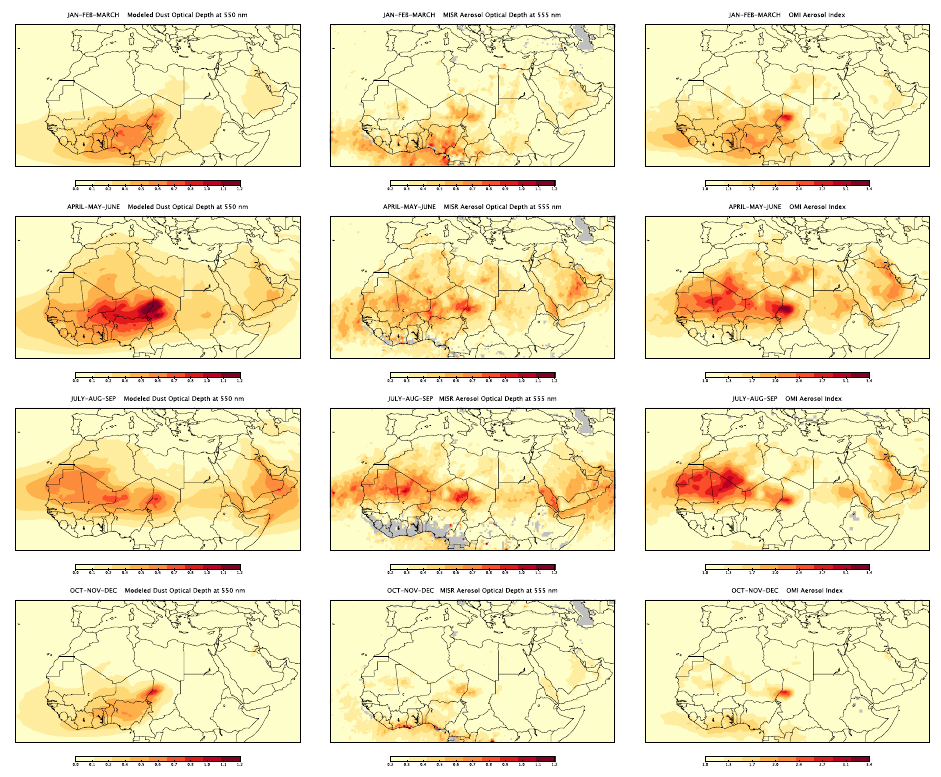
Fig. 4. Modeled dust AOD (left panels), MISR AOD (middle panels) and OMI Aerosol Index (right panels) for (from top to bottom) January-February-March (JFM), April-May-June (AMJ), July-August-September (JAS), October-November-December (OND) in 2006.